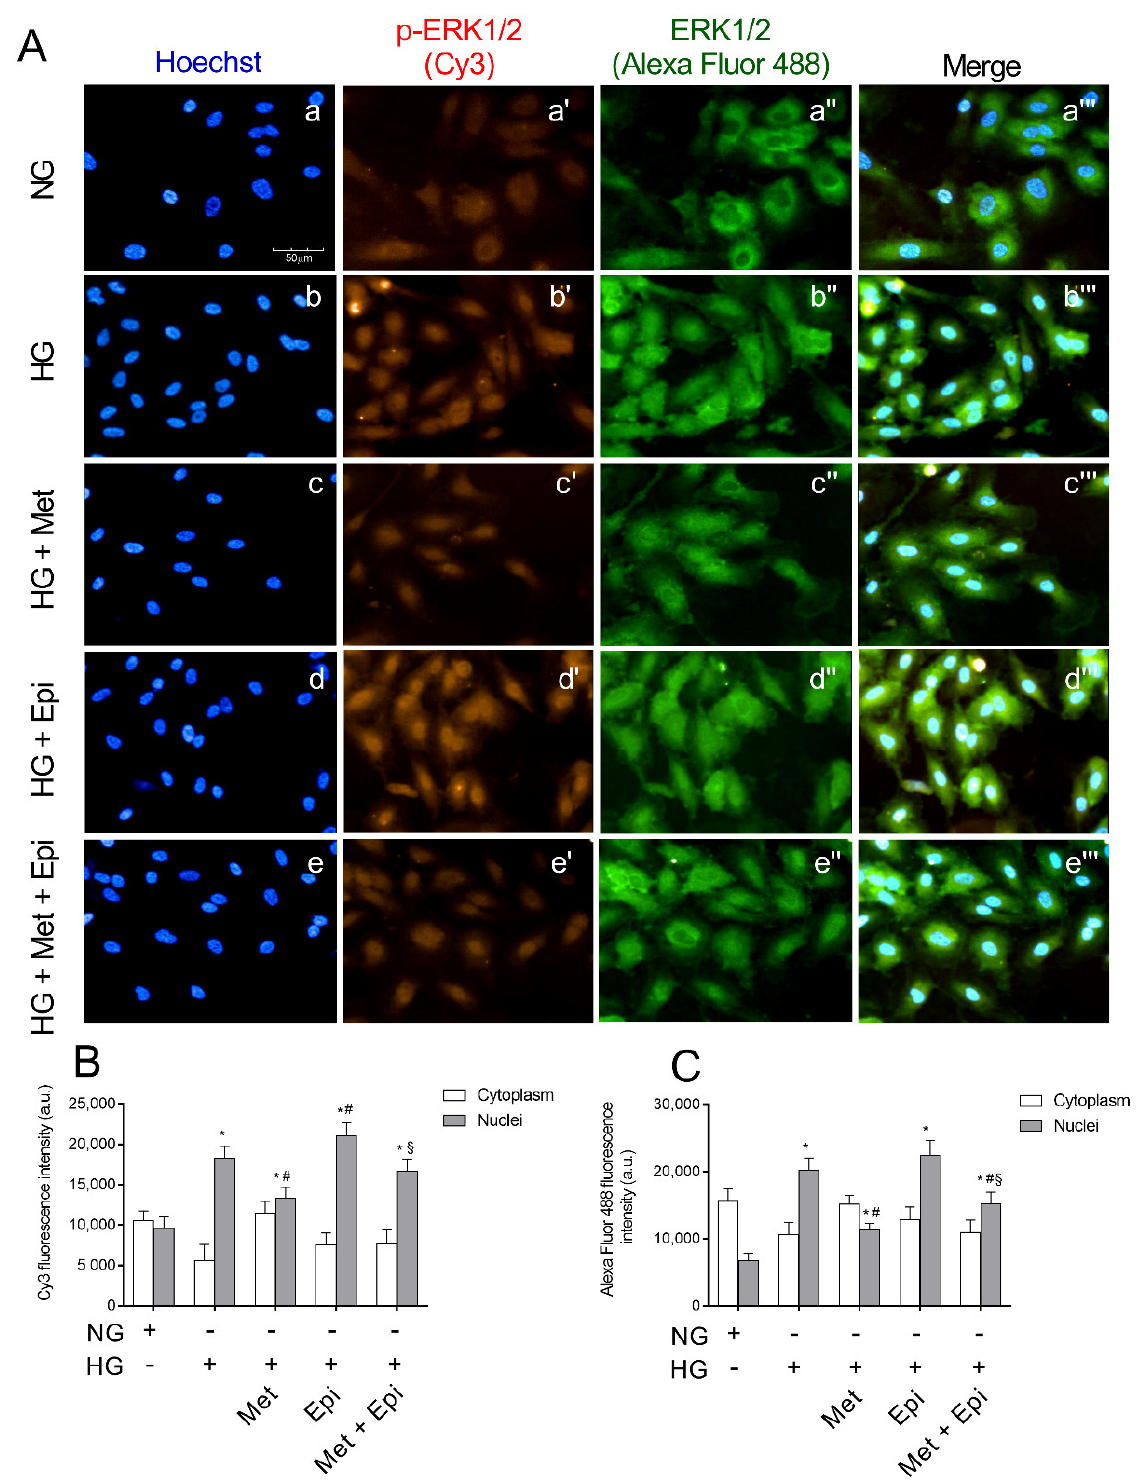
Figure 5. The effects of metoprolol and epinephrine on ERK1/2 nuclear translocation as assessed by immunocytochemistry in HREC that was treated with HG. ( A ) Representative images of immuno- cytochemical staining for phospho-ERK1/2 (p-ERK1/2) and total ERK1/2 (ERK1/2,) in HREC. In presence of normal glucose, Hoechst-stained cell nuclei (a), p-ERK 1/2 red fluorescence (a’), ERK 1/2 green fluorescence (a’’) and merged pictures (a’’’). In presence of high glucose, Hoechst-stained cell nuclei (b), p-ERK 1/2 red fluorescence (b’’), ERK 1/2 green fluorescence (b’’) and merged pictures (b’’’). In presence of high glucose and metoprolol, Hoechst-stained cell nuclei (c), p-ERK 1/2 red fluorescence (c’), ERK 1/2 green fluorescence (c’’) and merged pictures (c’’’). In presence of high glucose and epinephrine, Hoechst-stained cell nuclei (d), p-ERK 1/2 red fluorescence (d’), ERK 1/2 green fluorescence (d’’) and merged pictures (d’’’). In presence of high glucose plus metoprolol and